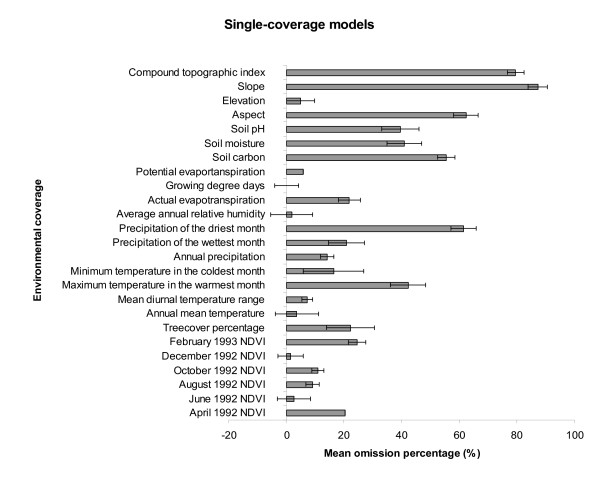
Relative contributions of single-data environmental data sets. Horizontal bar graph presents a summary of results of single-data coverage model analyses, indicating mean omission percentages (and standard deviations) calculated based on predictions of 10 best-subset models and independent testing points. Note that positive contribution by the variable is indicated by low values in the single-coverage models.